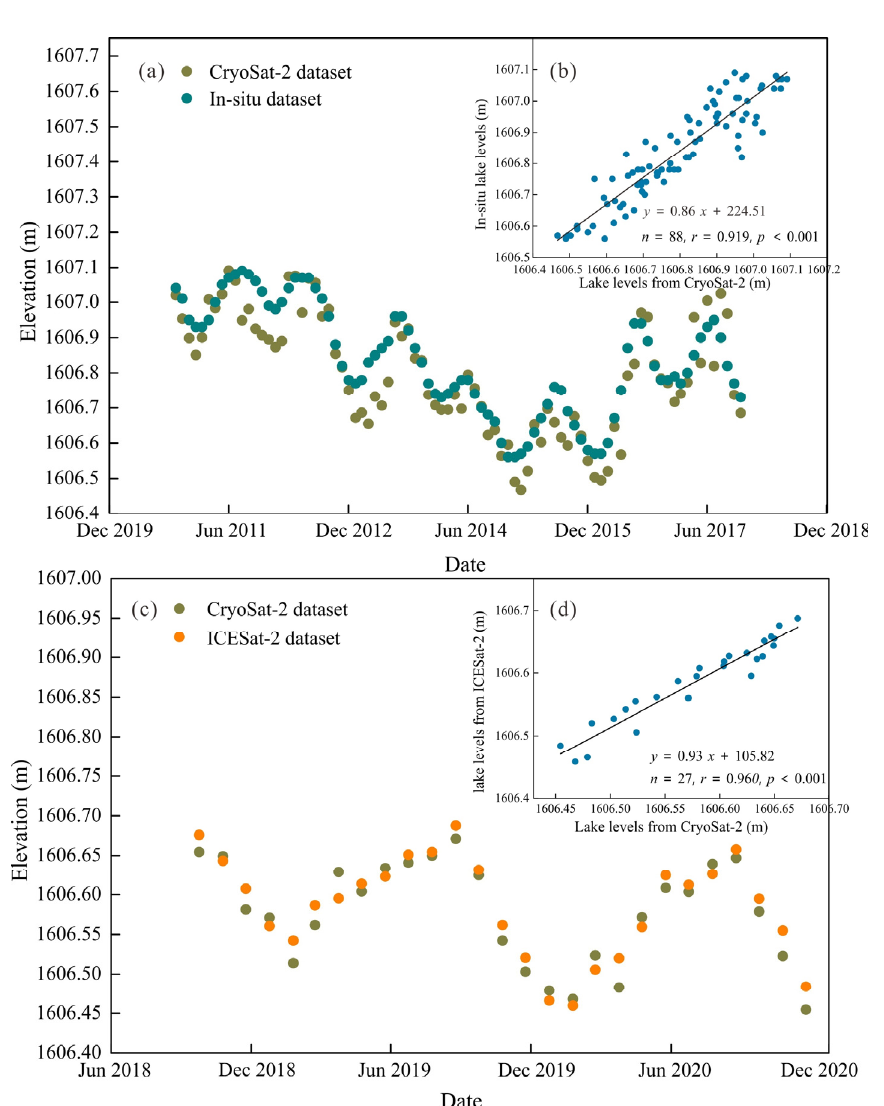
Figure 9. The comparison of the CryoSat-2 dataset with ( a ) the in situ dataset and ICESat-2 dataset ( c ) and the correlation analysis of the CryoSat-2 dataset with ( b ) in situ data and ( d ) the ICESat-2 dataset. Table 3. Evaluation metrics.